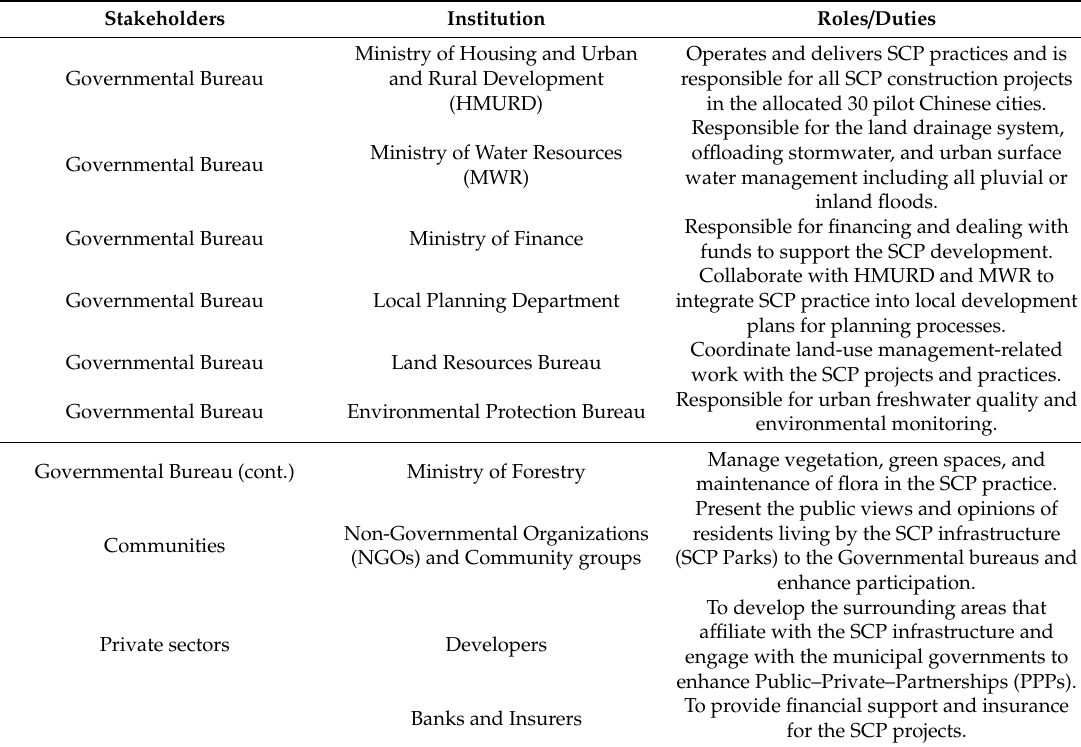
Table 2. Major stakeholders and their roles and functions of the SCP in pilot cities